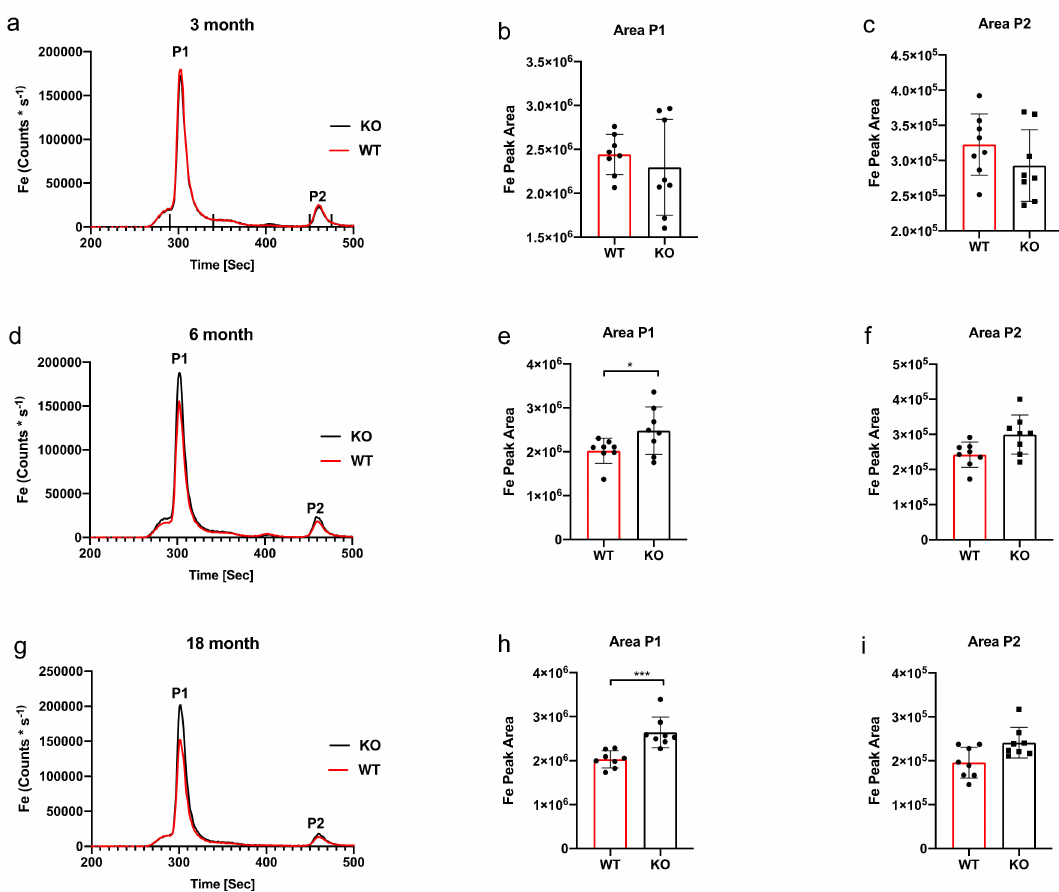
Figure 1. Inductively coupled plasma mass spectrometry (ICPMS) and area under the curve Fe analysis. No significant di ff erence in Fe was observed between wild-type (WT) and knockout (KO) mice at the 3-month time point ( a ) further reflected in the area under the curve (AUC) analysis for peak 1 ( b ) and peak 2 ( c ). The ticks above the x-axis indicate the integration windows for the AUC analysis. There was a decrease in Fe observed in the ICPMS chromatogram ( d ) at the 6-month time point that was revealed to be significant for peak 1 (* p = 0.01) ( e ) and no change for peak 2 ( f ). At the 18-month time point there was a decrease in Fe observed in the ICPMS chromatogram ( g ) that was revealed to be significant for peak 1 (*** p = < 0.0001) ( h ) and no change for peak 2 ( i ). Dot plots and bar graph show the mean and SD, peak area statistical comparison one-way ANOVA Sidak’s multiple comparison